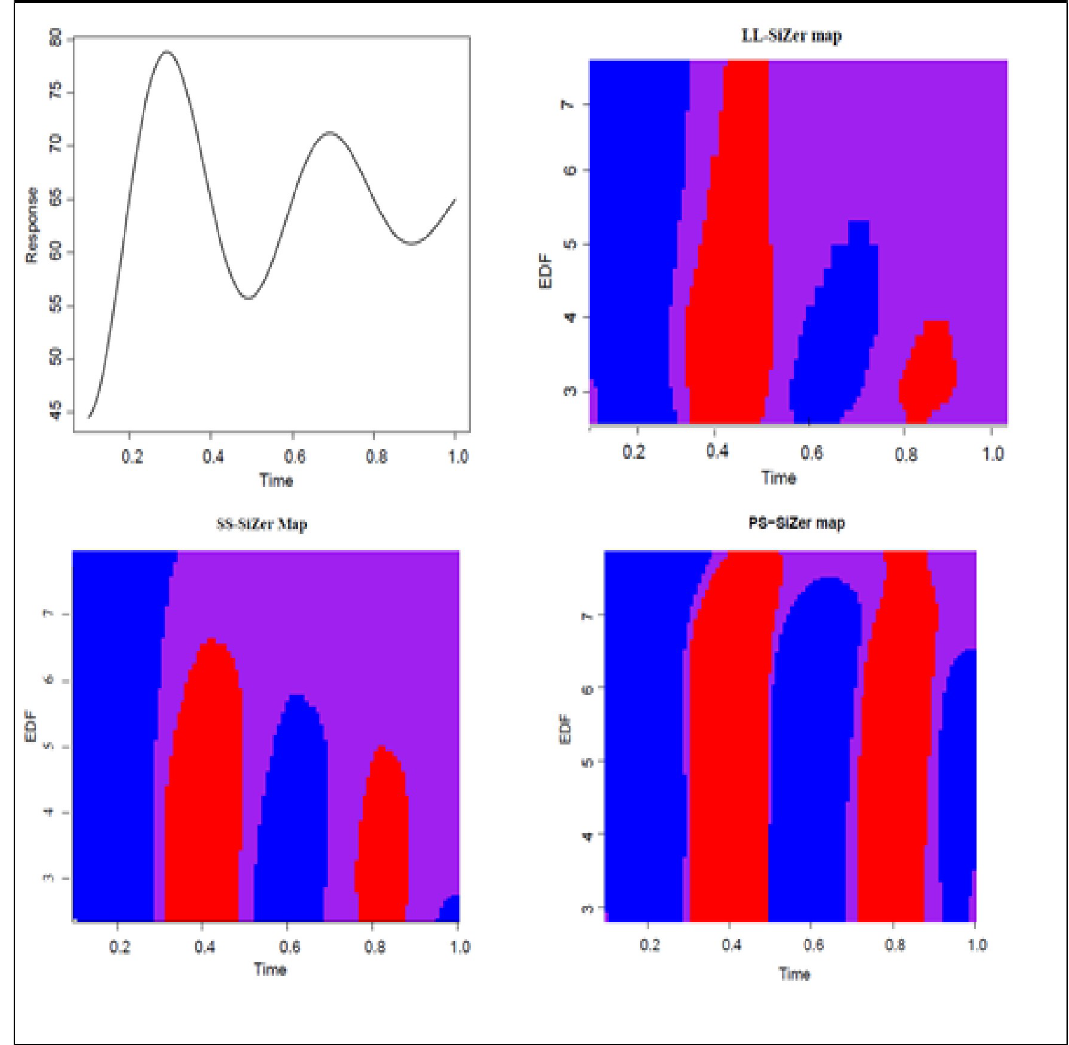
Fig 2. Simulation study 1. Upper-left panel: True function; Upper-right panel: LL-SiZer map. Lower-left panel: SS-SiZer map. Lower-right panel: PS-SiZer map. For the SiZer maps, vertical axis represents 100 levels of EDF and the horizontal axis represents